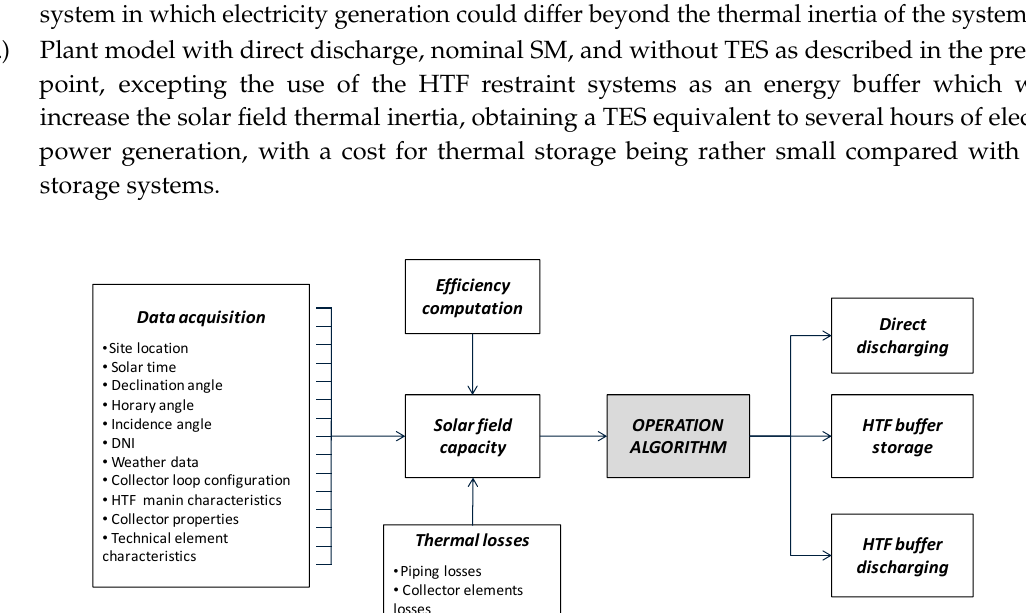
Figure 7. Functional unit for power block and net electric energy output models.